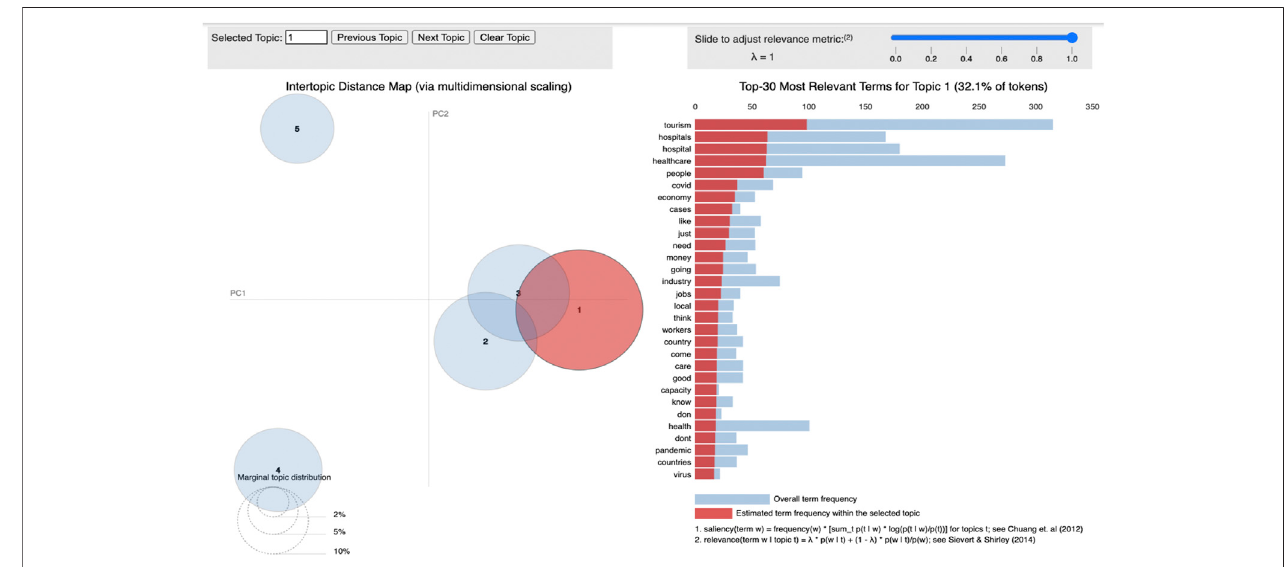
FIGURE 4 | Interactive topic modeling visualization for tourism healthcare